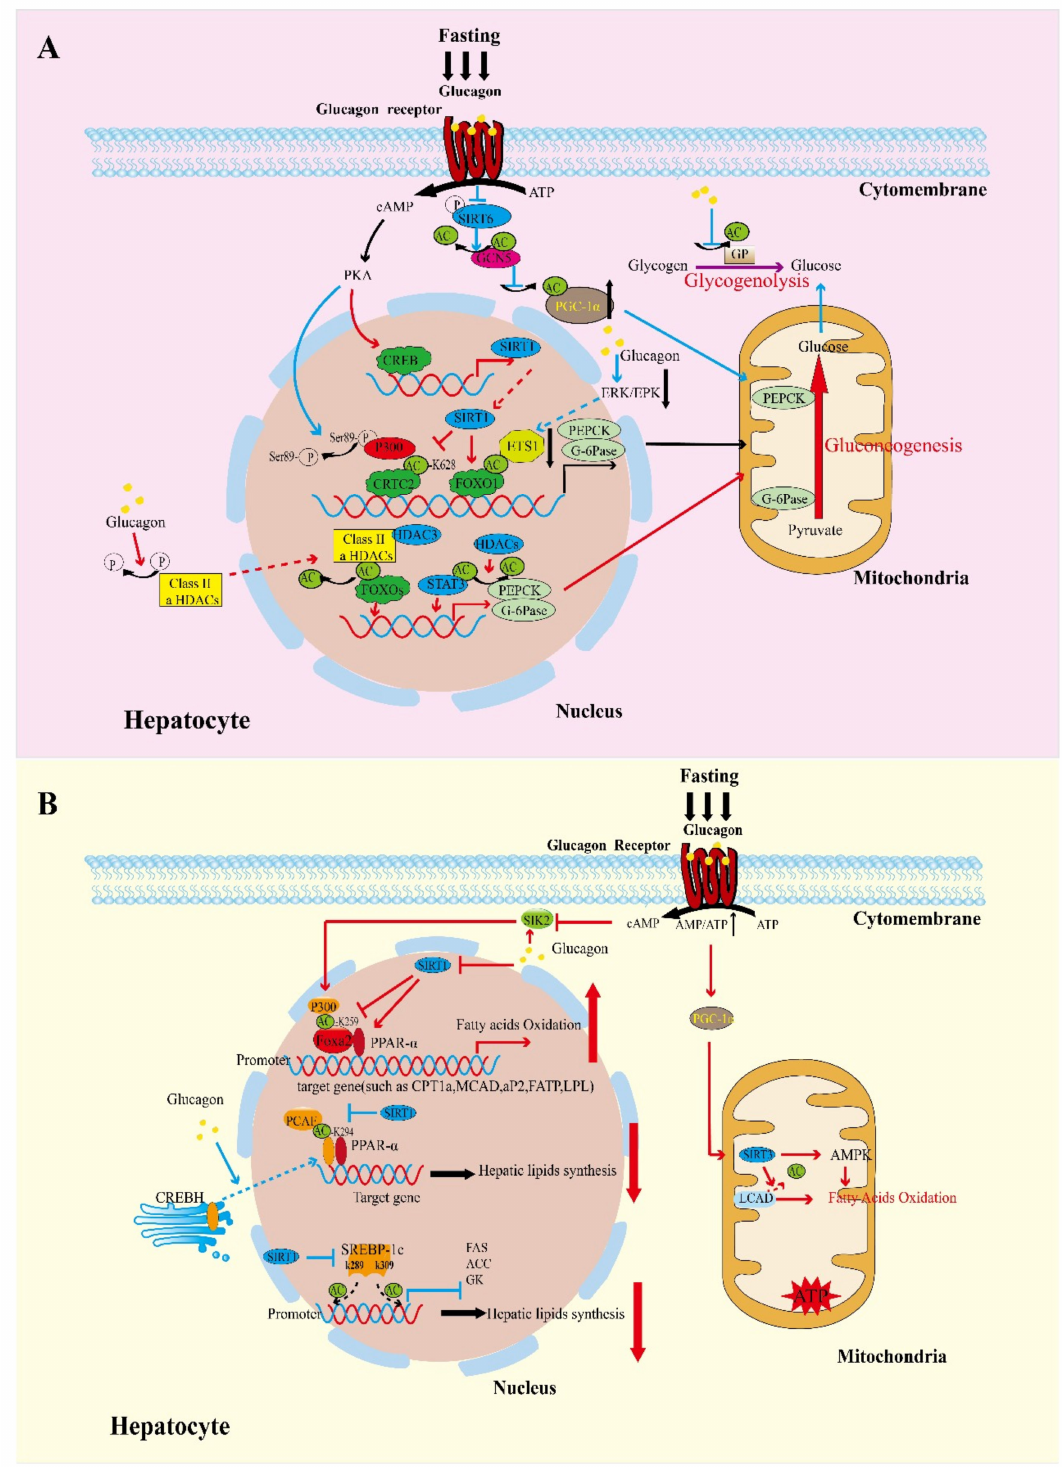
Figure 1. Glucagon-induced acetylation of energy-sensing factors in control of hepatic glycolipid metabolism. ( a ) Blue arrow: Glucagon initiates the transcription of downstream G6Pase and PEPCK1 by inducing acetylation of CRTC2 and FOXO1 and reducing acetylation of PGC-1 α and GP, which leads to elevating